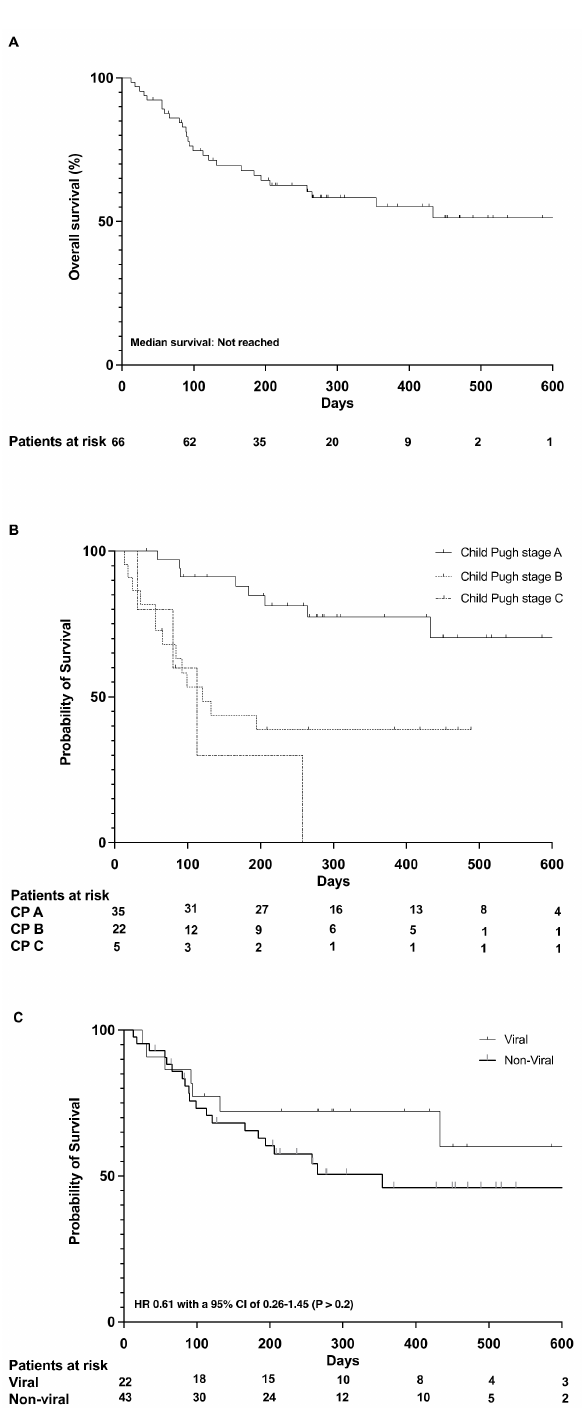
Figure 2. Overal survival ( A ); Survival according to Child Pugh stage ( B ); Survival according to viral and non-viral etiology ( C